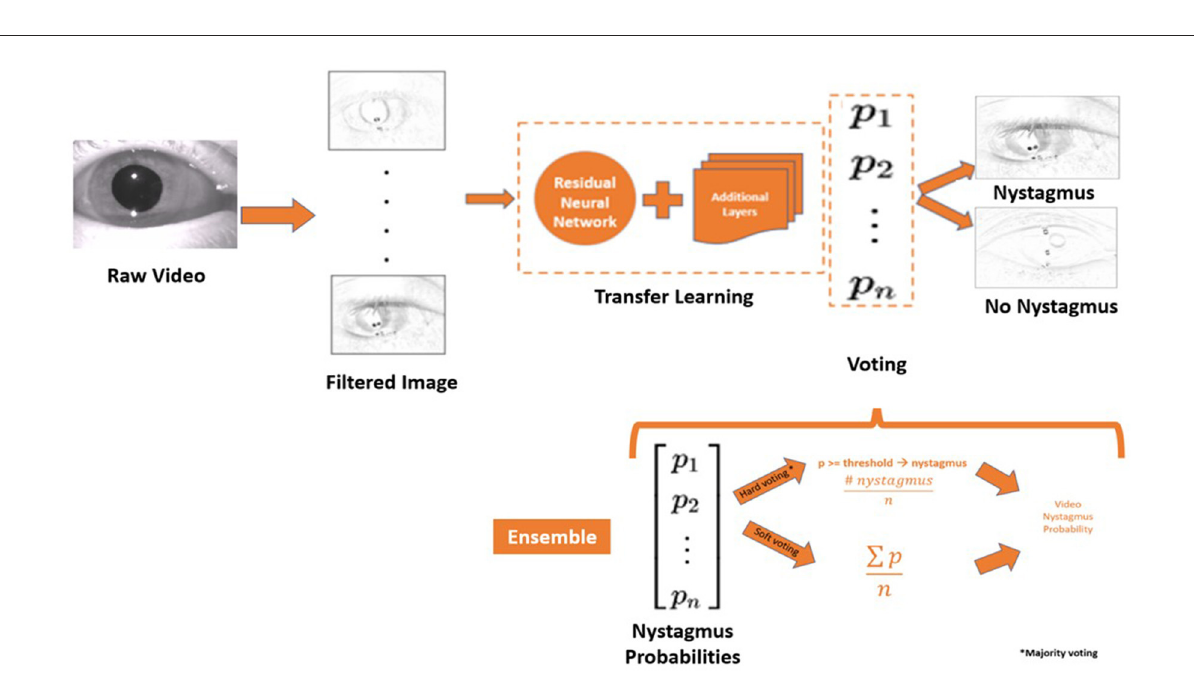
FIGURE6 Model architecture and the framework of the ensemble model. P , probability; n , number of filtered images; P , the sum of; n , number of filtered